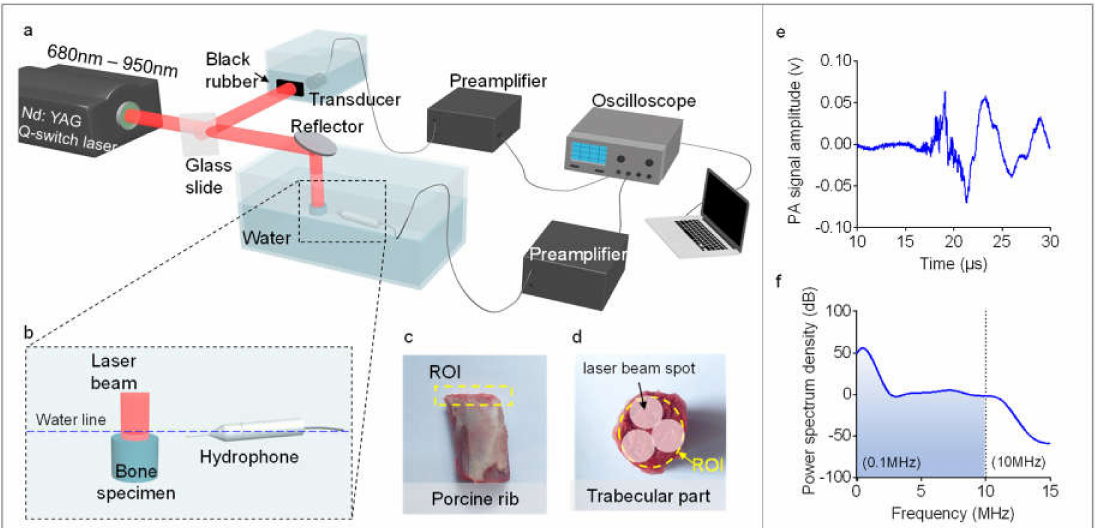
Figure 1. Experimental setup. ( a , b ) The schematic diagram of the experiment setup. ( c , d ) The photographs of the bone samples. ROI stands for the regions of interest. ( e ) An example of the photoacoustic (PA) signal generated by the bone specimen. ( f ) An example of the power spectrum density (PSD) of the PA signal generated by the